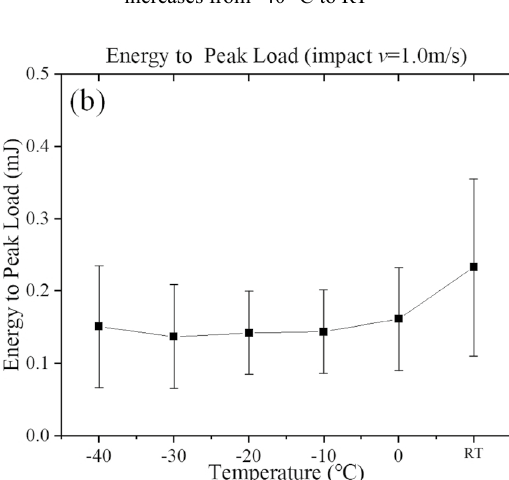
Hardness vs. radiation dose.